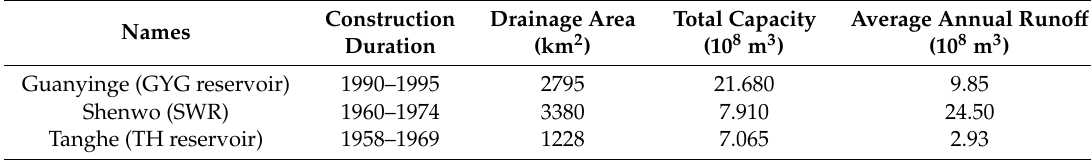
Table 1. Information of major water reservoirs in Taizi River